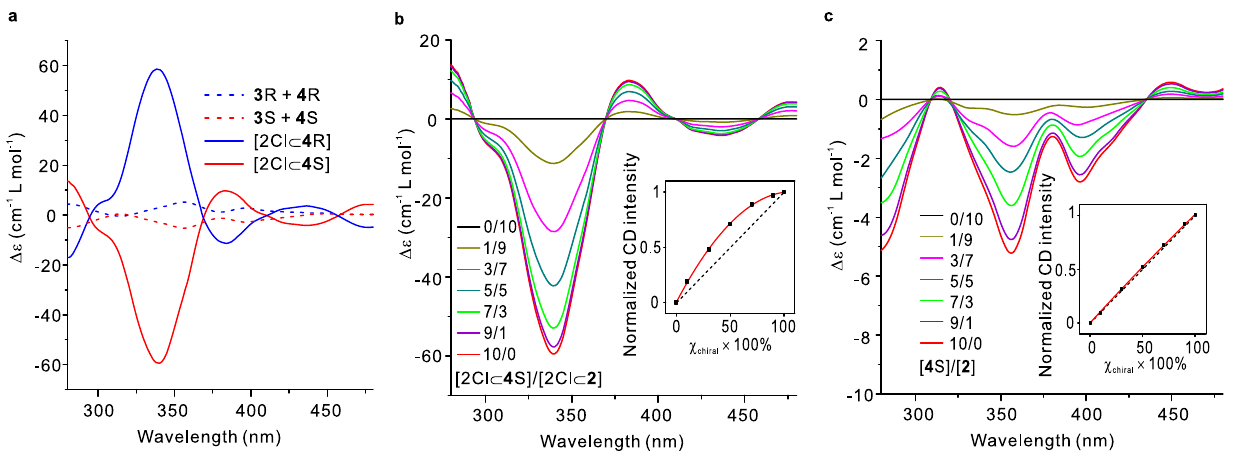
Fig. 5 Chiral transmission and ampli fi cation from side chains to backbones. a Circular dichroism spectra in CH 3 CN of 3 R and 4 R mixture ([ 3 R] + 2[ 4 R] = 1 × 10 − 4 M, blue dashed line), 3 S and 4 S mixture ([ 3 S] + 2[ 4 S] = 1 × 10 − 4 M, red dashed line), [2Cl ⊂ 4 R] (1 × 10 − 4 M, blue solid line), and [2Cl ⊂ 4 S] (1 × 10 − 4 M, red solid line). b Main fi gure, circular dichroism spectra in CH 3 CN for mixtures of [2Cl ⊂ 2 ] and [2Cl ⊂ 4 S] at various molar ratios at equilibria (the total concentration is kept constant at 1 × 10 − 4 M). Inset, a plot of the normalized intensities at 331 nm versus the percentages of [2Cl ⊂ 4 S]. c Main fi gure, circular dichroism spectra in CH 3 CN for mixtures of 2 and 4 S at various molar ratios at equilibria (the total concentration is kept constant at 1 × 10 − 4 M). Inset, a plot of the normalized intensities at 359 nm versus the percentages of 4